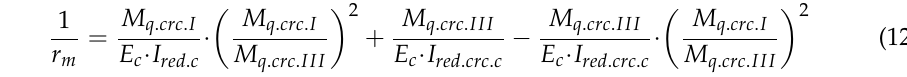
Figure 13. Distribution of cracks at voids and webs.